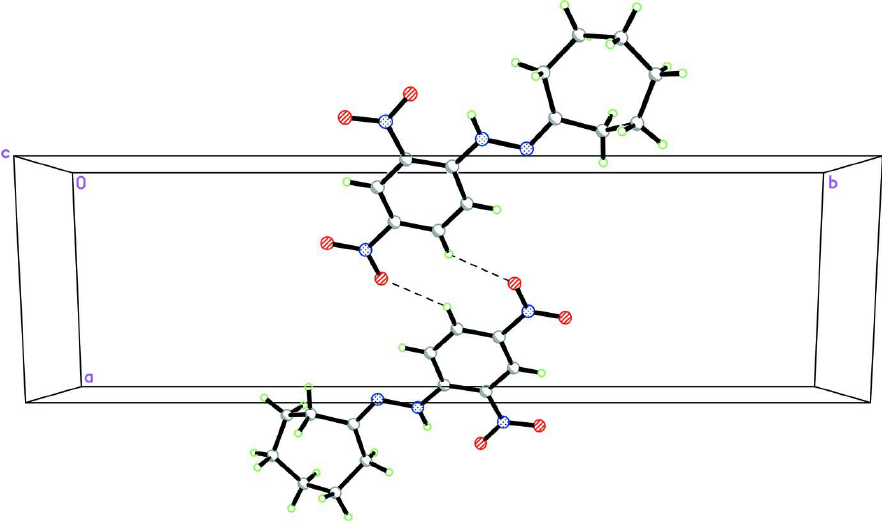
Figure 1 View of the molecular structure of the title compound with atom labels and 50% probability ellipsoids for non-H atoms. Intramolecular hydrogen bond is shown as dash lines.